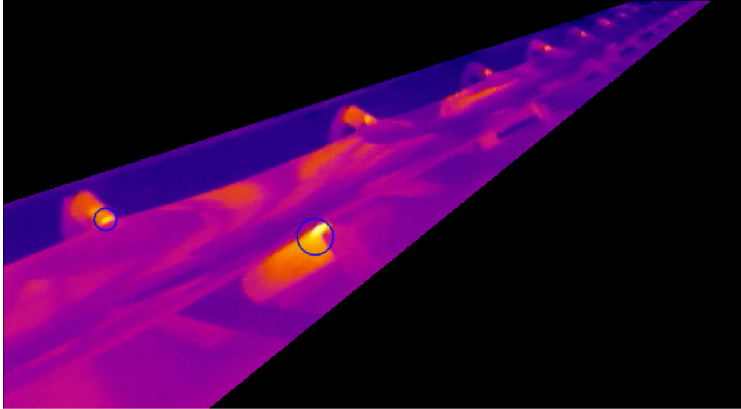
Figure 15. Result of damaged idler detection, example 4. For better visualization of the method results, cropped ROI with detected idlers was applied on the original RGB frame in Figure 16. The differently colored part of the shown image represents an actual ROI cropped out by the proposed algorithm.